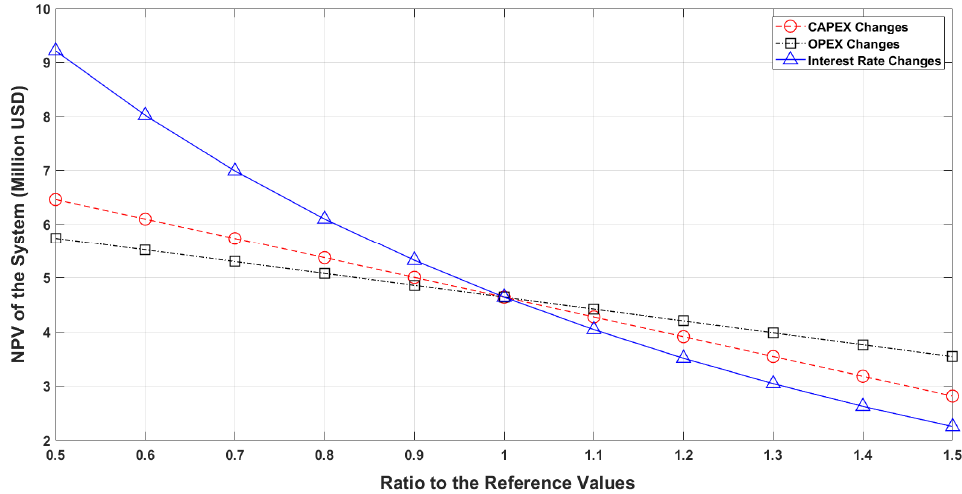
Figure 15. Sensitivity analysis of the economic proficiency of the proposed solution.